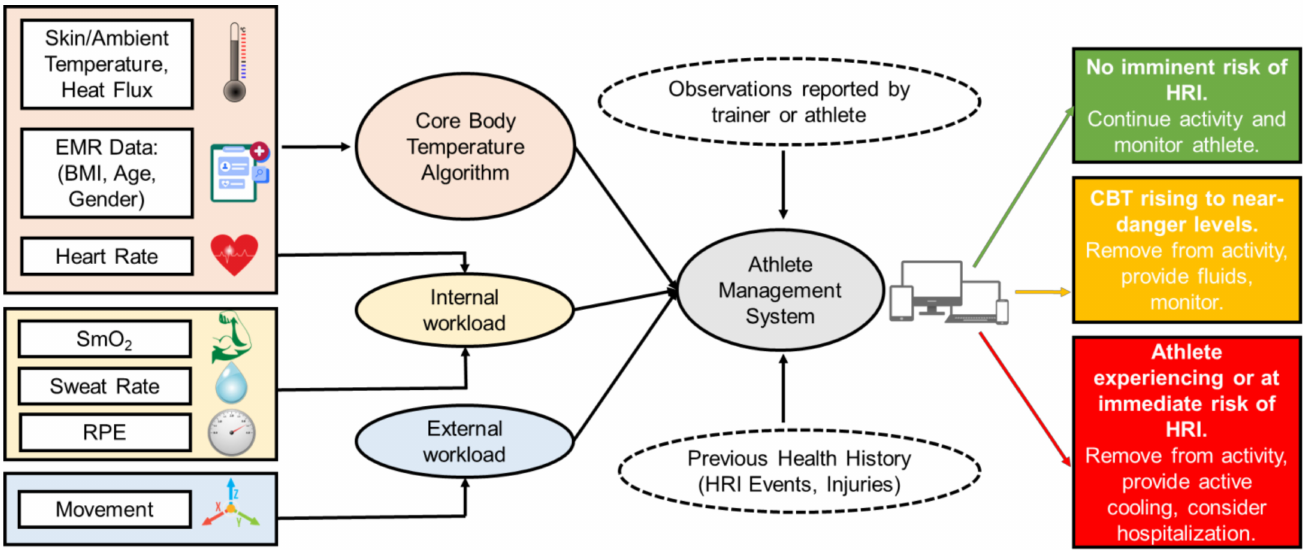
Figure 5. A workflow schematic depicting the hypothetical interoperability of an algorithm for CBT prediction using wearable devices [25–27,54]. Both sensor inputs to the CBT prediction algorithm and its output to other systems are included in the schematic. Heart Rate is used to calculate both the CBT and internal workload. EMR = Electronic Medical Record, RPE = Rating of Perceived Exertion, and SmO 2 = Muscle Oxygen